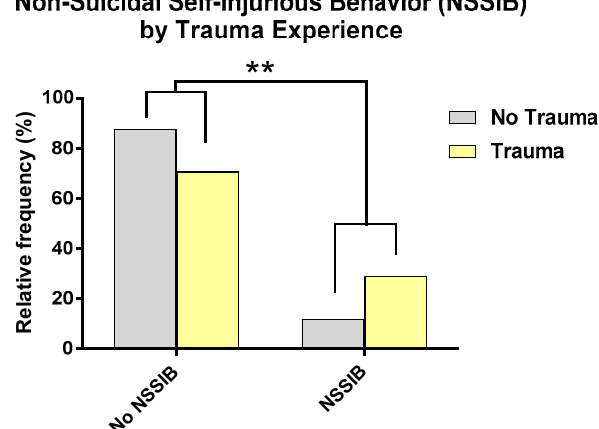
Figure 4. Participants with a history of NSSIB were more likely to report a history of trauma than those without NSSIB. ** p < 0.01.